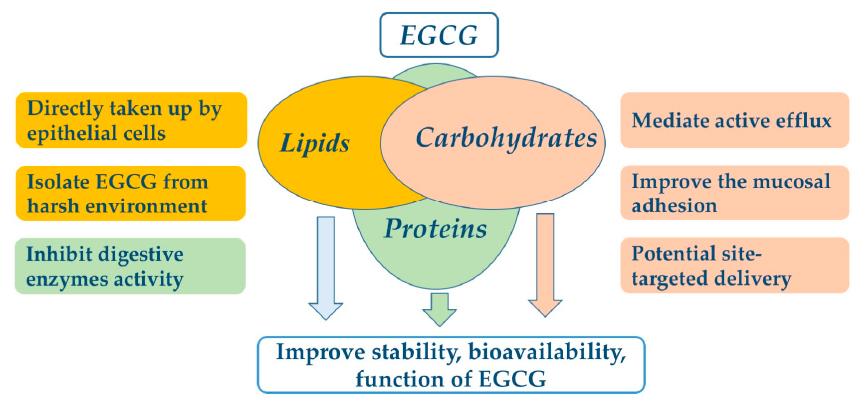
Figure 2. The potential mechanisms of food-grade encapsulate for improving EGCG